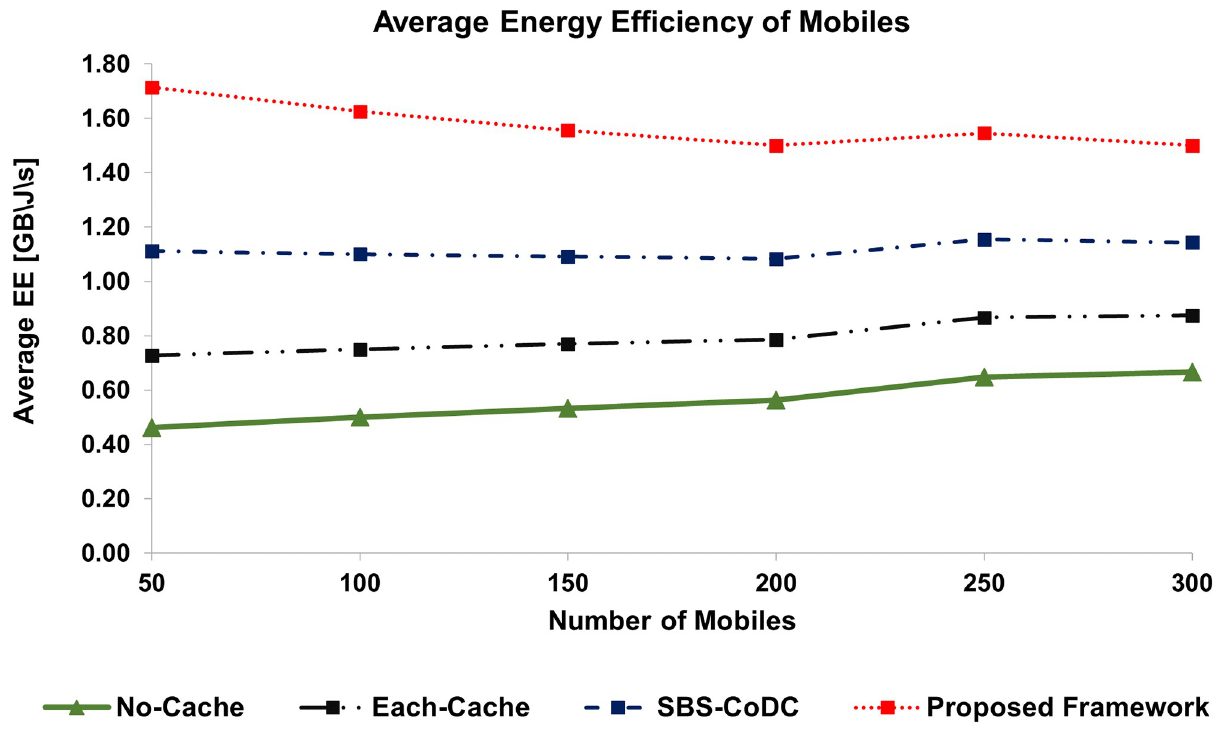
Fig 10. Comparison average EE of MSs among existing